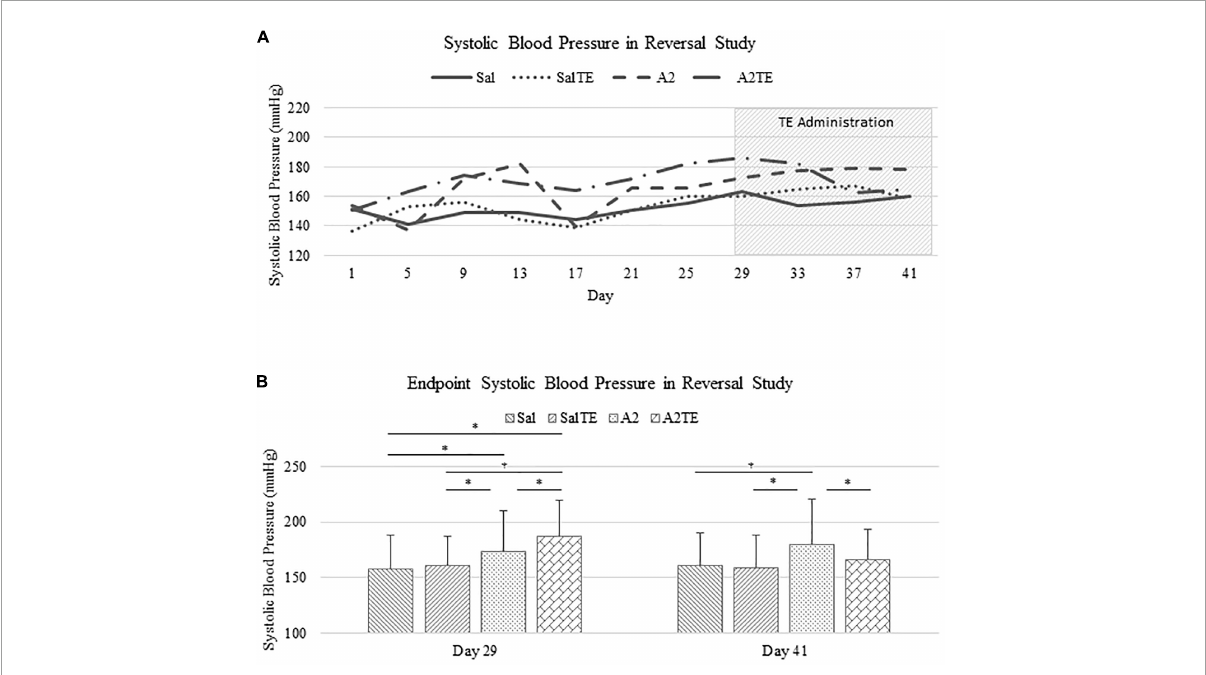
FIGURE3 (A) Systolic blood pressure changes with time in hypertensive and normotensive mice in reversal study. (B) Endpoint (Day 29 and 41) systolic blood pressure comparison across treatments. Asterisk indicates significant difference ( p <